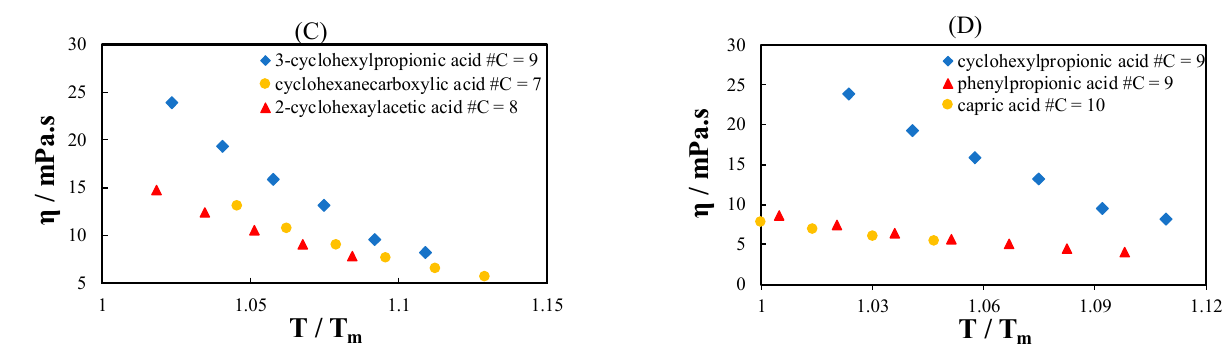
Figure 1. Viscosity of ( A ) linear acids, ( B ) phenyl acids, ( C ) cyclohexyl acids, and ( D ) acids with a similar number of carbon atoms with different hydrocarbon side chains as a function of temperature divided by the melting temperature of the pure acid. Filled symbols are data measured in this work, and cross symbols in ( A ) are data in the literature from Wang et al. [26].